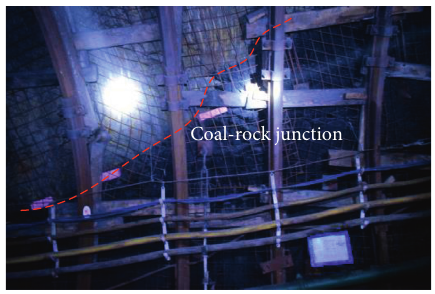
Figure 1: Coal-rock interaction